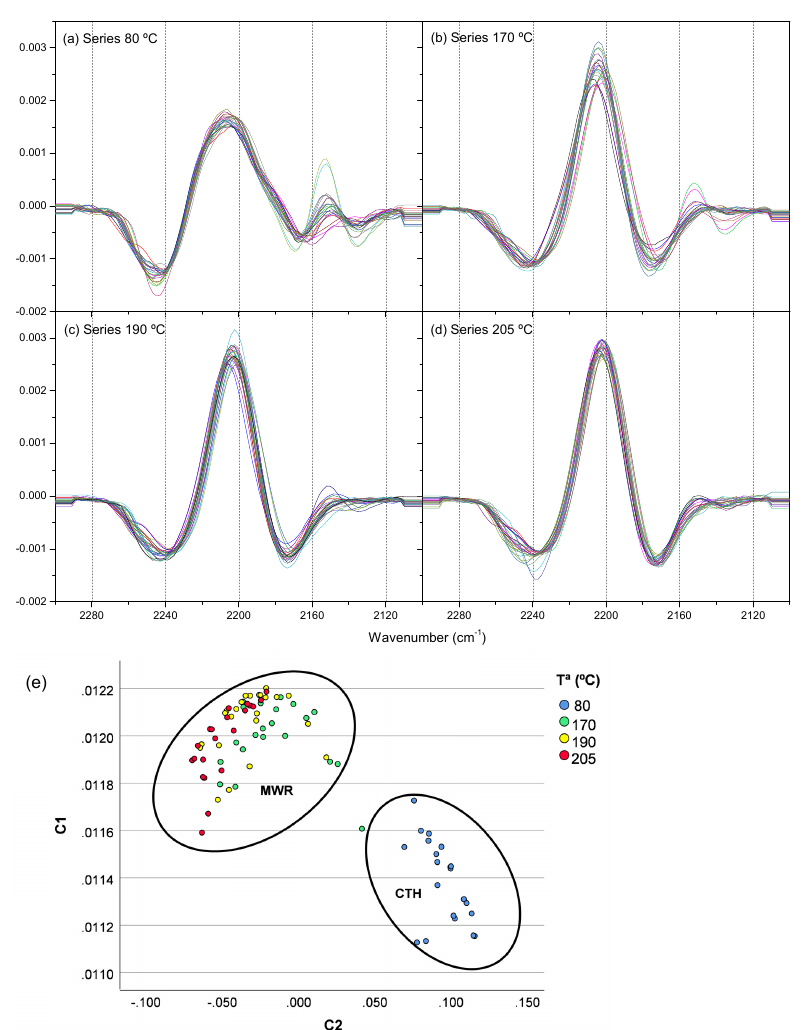
Figure 6. Second spectral derivatives in the FTIR nitrile spectral region (2300–2100 cm − 1 ) from gel fractions of the cyanide polymerizations: ( a ) using conventional heating at 80 °C and ( b − d ) assisted by MWR at different temperatures, 170, 190 and 205 °C, respectively; (e) PCA of the dispersion of the second derivatives of the IR nitrile spectral region (2300 − 2100 cm − 1 ). The FTIR spectra are from each of the triplicates of the samples synthesized using the conditions shown in Table S1 (please compare with the dendrogram in Figure S6). The second derivatives of the FTIR spectra of the 80 °C series correspond to the FTIR spectra previously reported in [29], shown here as control experiments. A total of ninety FTIR spectra were considered (Figure S6). Similar to Figure 4, the experiments